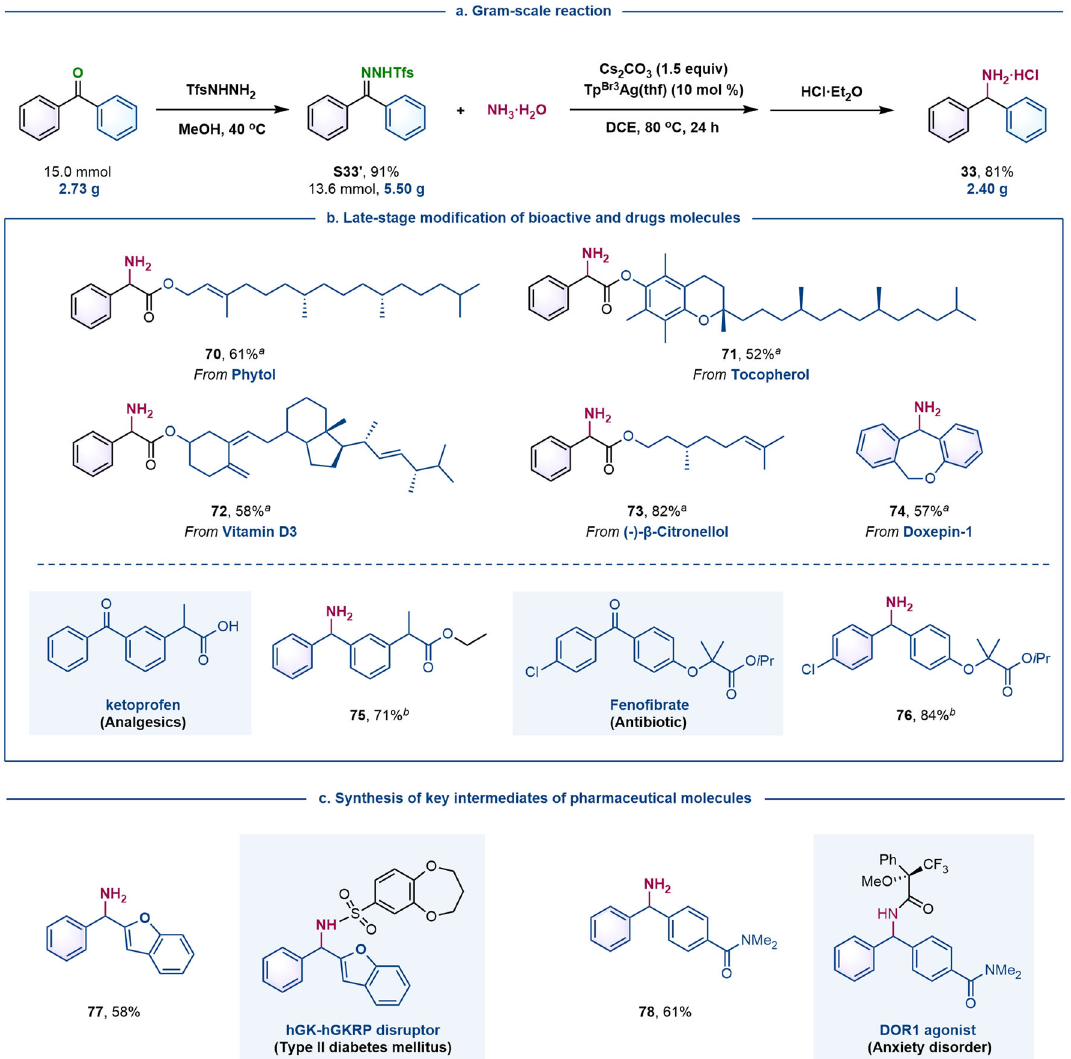
Fig.3|Syntheticapplications.a Gram-scalereaction. b Late-stagetransformation of bioactive and drug molecules. a Started from the corresponding diazo com- pound. b Started from the corresponding N -triftosylhydrazone. c